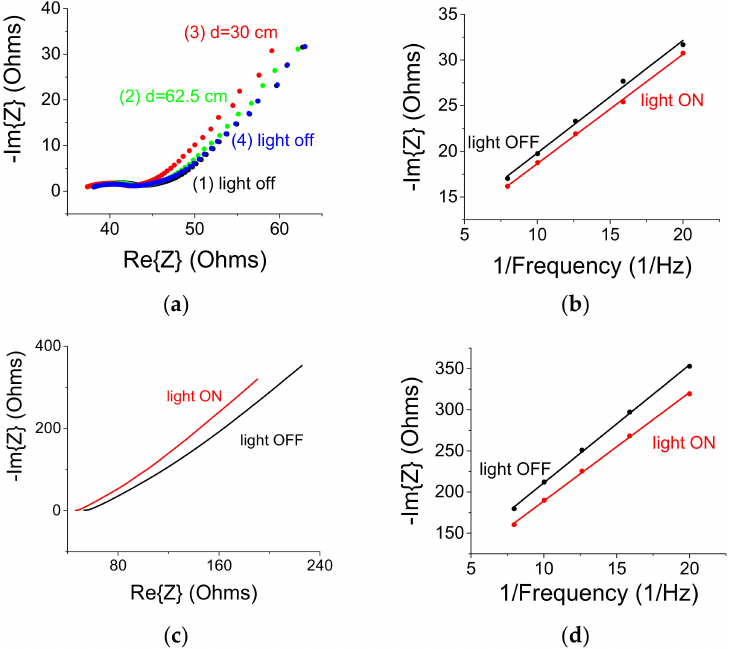
Figure 5. ( a ) An EIS Nyquist curve as a function of light. (1) White light OFF. (2) White light ON placed at distance d = 62.5 cm from the sample (translated to I = 3 mW/cm 2 at the sample surface). (3) The white light was brought closer to the sample (d = 30 cm, I = 30 mW/cm 2 ). (4) The white light source was turned OFF and its related curve follows case (1). ( b ) Plot of − Im{Z} vs. the inverse of the frequency exhibits a straight line with a slope proportional to the differential capacitance. ( c ) A sample with a high (imaginary) impedance exhibits a larger optical effect and its related differential capacitance curve is shown in ( d ). Note that under white light illumination, the slope of the curve, which is proportional to the inverse of the differential capacitance